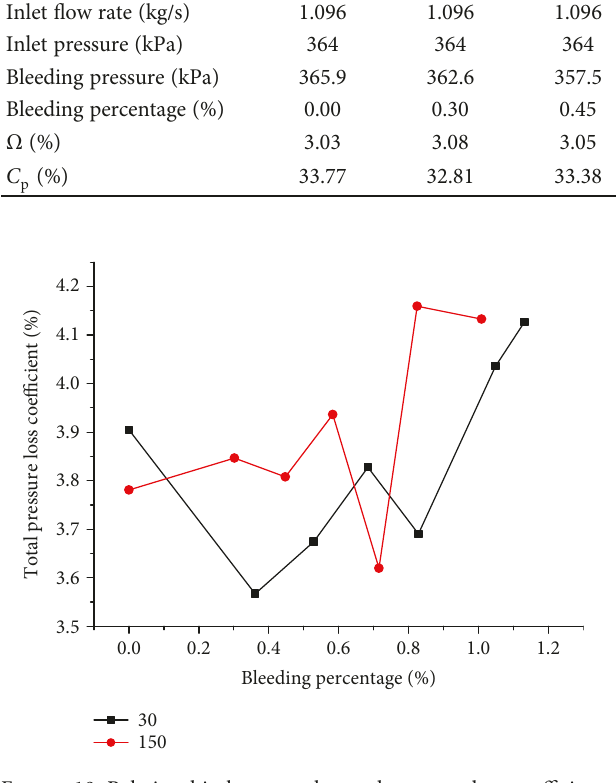
Figure 19: Relationship between the total pressure loss coe ffi cient and the bleeding percentage (1.20 expansion ratio).